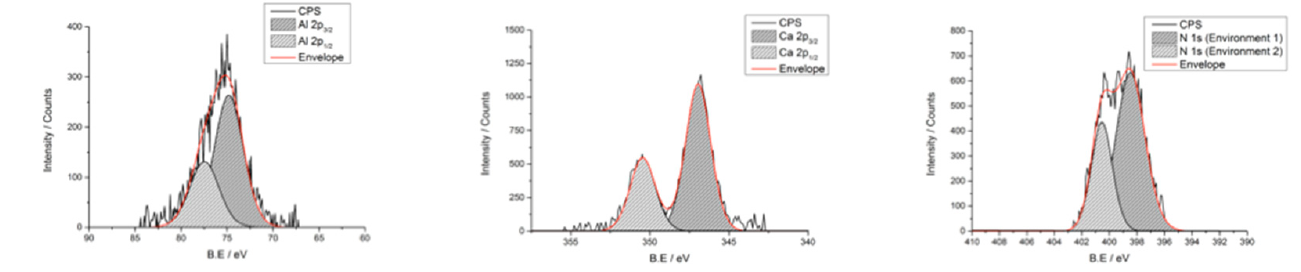
Figure 5. Effect of cleaning procedures on the Ti oxide layer (TiO 2 ) surface properties. X-ray photo- electron spectroscopy high resolution scans detected peaks for Al(2p), Ca(2p) and N(1s). Samples were sputtered using a 2 kV argon ion gun; the sputtering rate was 1 angstrom per second.